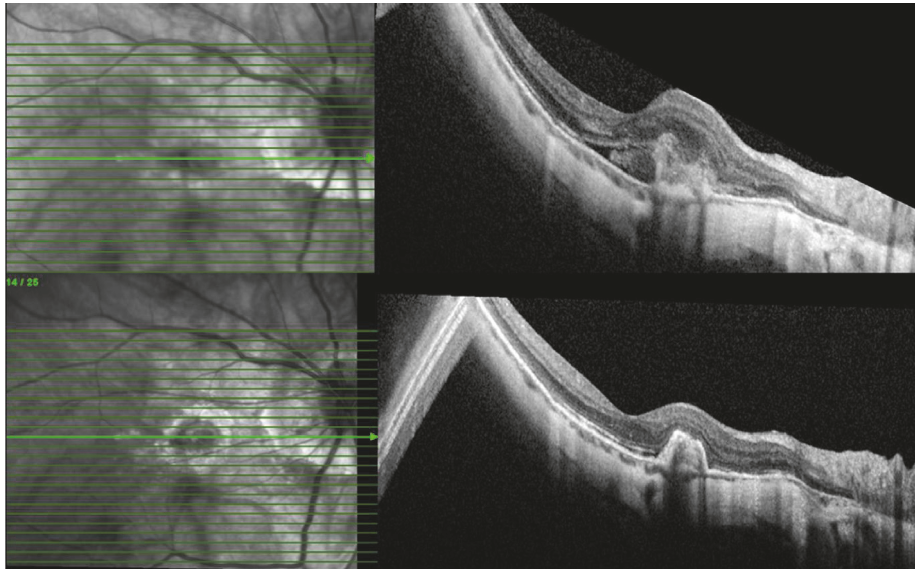
Figure 3: In the case of the IVA group, the mCNV-associated subretinal fluid totally regresses following two monthly IVA injections; the type I component of mCNV is still present at the following visit.